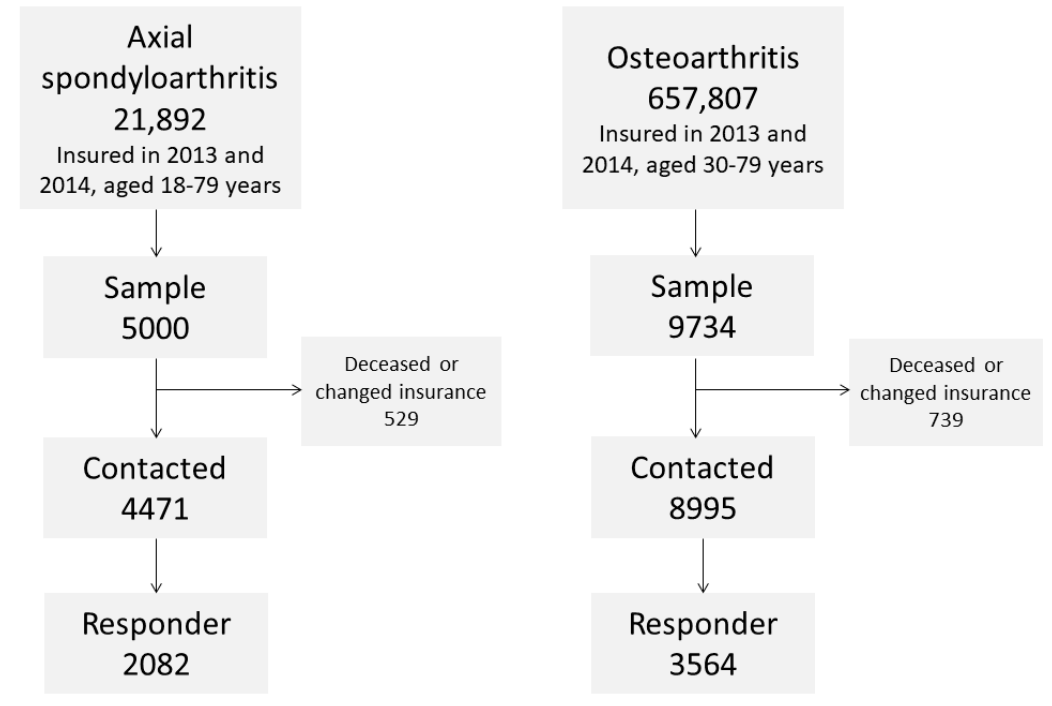
Figure 1. Flowchart showing sample sizes in the surveys.